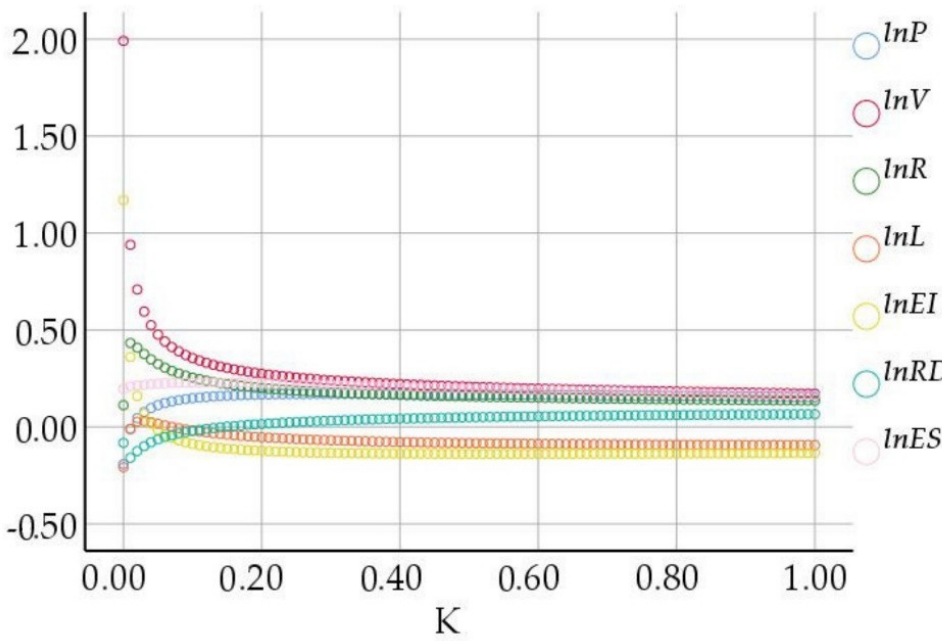
Figure 2. R 2 diagram corresponding to K value.